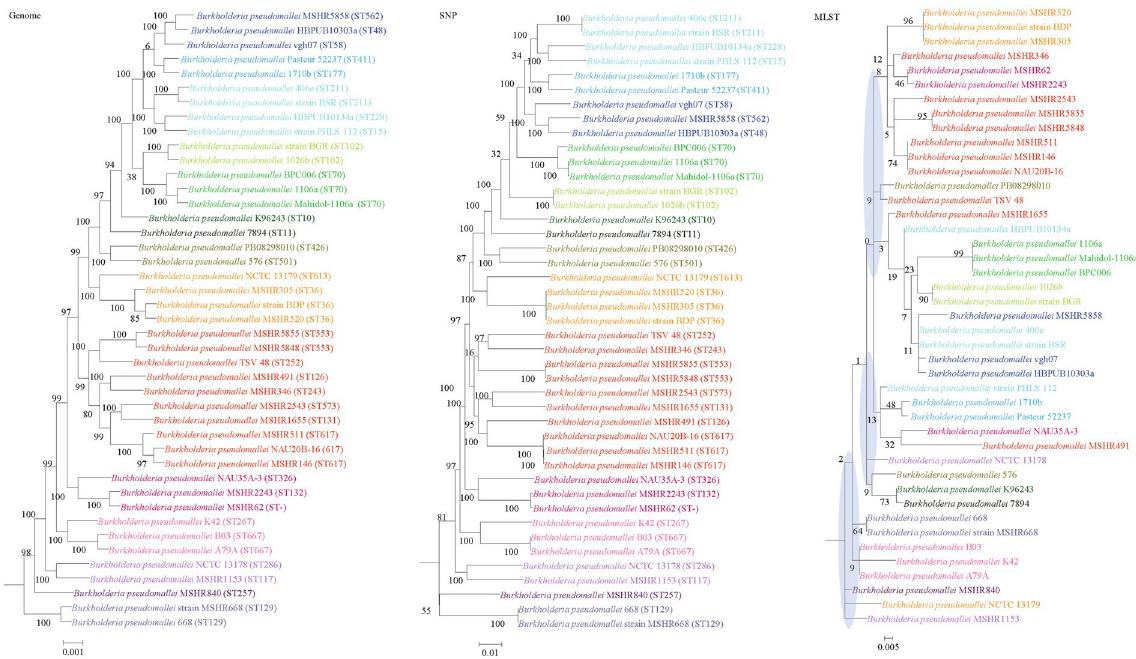
Figure 2. Comparison of phylogenetic trees constructed using genome data (left), SNP data (middle), and MLST data (right) for Burkholderia pseudomallei (chromosome I). Clusters that were manually selected based on the genome trees are illustrated in different colors. The unresolved polytomies are shaded in blue. A new sequence type is represented by a dash (“ST-”).